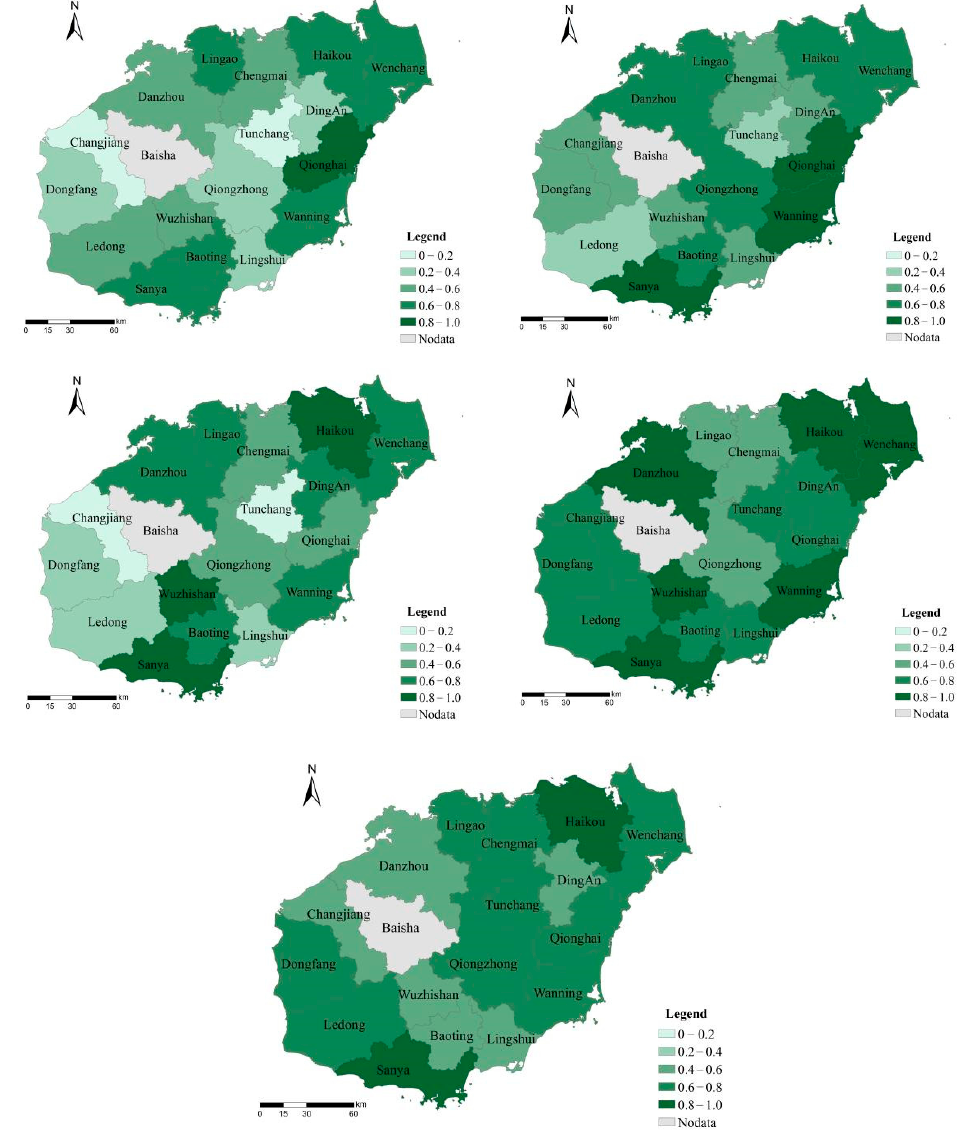
Figure 2. The evolution of the spatial and temporal pattern of tourism development efficiency of Hainan Island. In 2001, 2005, 2010, 2015 and 2020. Hainan Island. In 2001, 2005, 2010, 2015 and